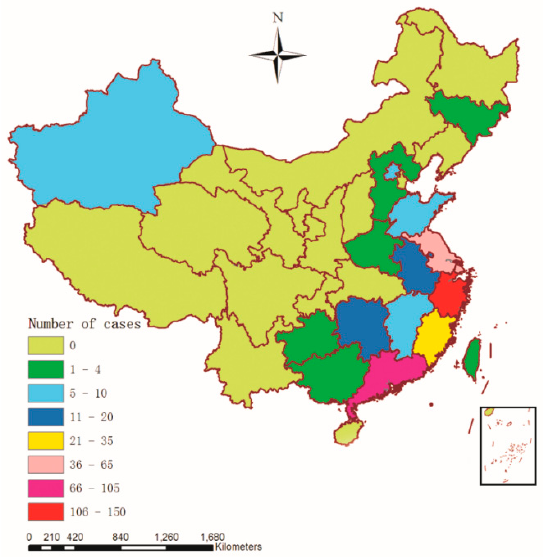
Figure 3. H7N9 persistence as measured by the cumulative number with reported outbreaks (March